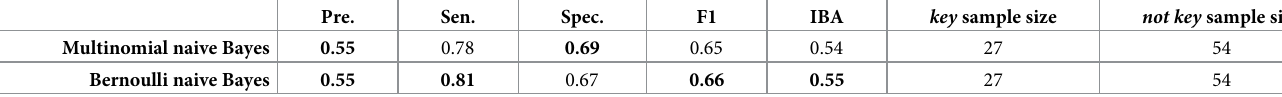
Table 1. Evaluation of the key date extraction. Pre. Sen. Spec. F1 IBA key sample size not key sample size Multinomial naive Bayes 0.55 Bernoulli naive Bayes For each classifier and label, the precision (Pre.), sensitivity (Sen.), specificity (Spec.), F1, index balanced accuracy (IBA) with α = 0.1, and sample size for both classes, key and not key , of the test set is given. The best values for each score highlighted in